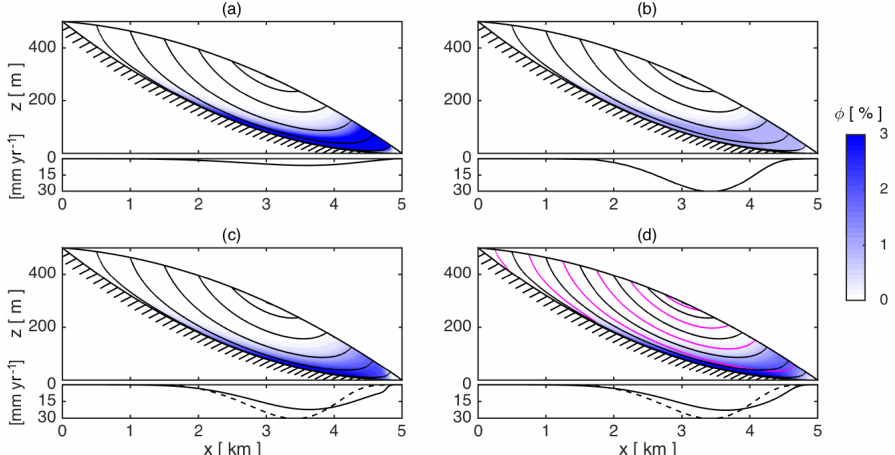
Figure 5. Temperate glacier solutions for (a, b) the standard enthalpy gradient model without and with drainage, (c) modified enthalpy gradient model, and (d) compaction pressure model. Shading shows porosity. Solid black lines show ice streamlines. Lower panels show water flux from the ice at the bed (in b , this includes the vertically integrated drainage R D(φ) d z ); dashed lines are replicas of that from (b) for comparison. Pink lines in (d) show liquid water streamlines.